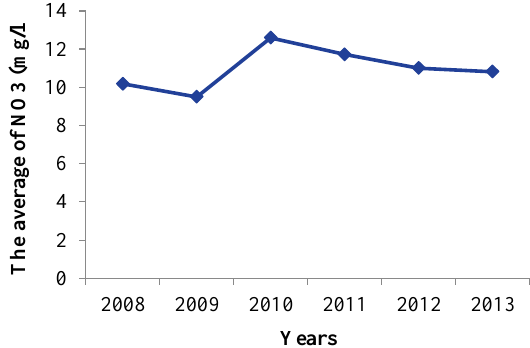
Figure 6. The average concentration of Nitrate by season 2008-2013